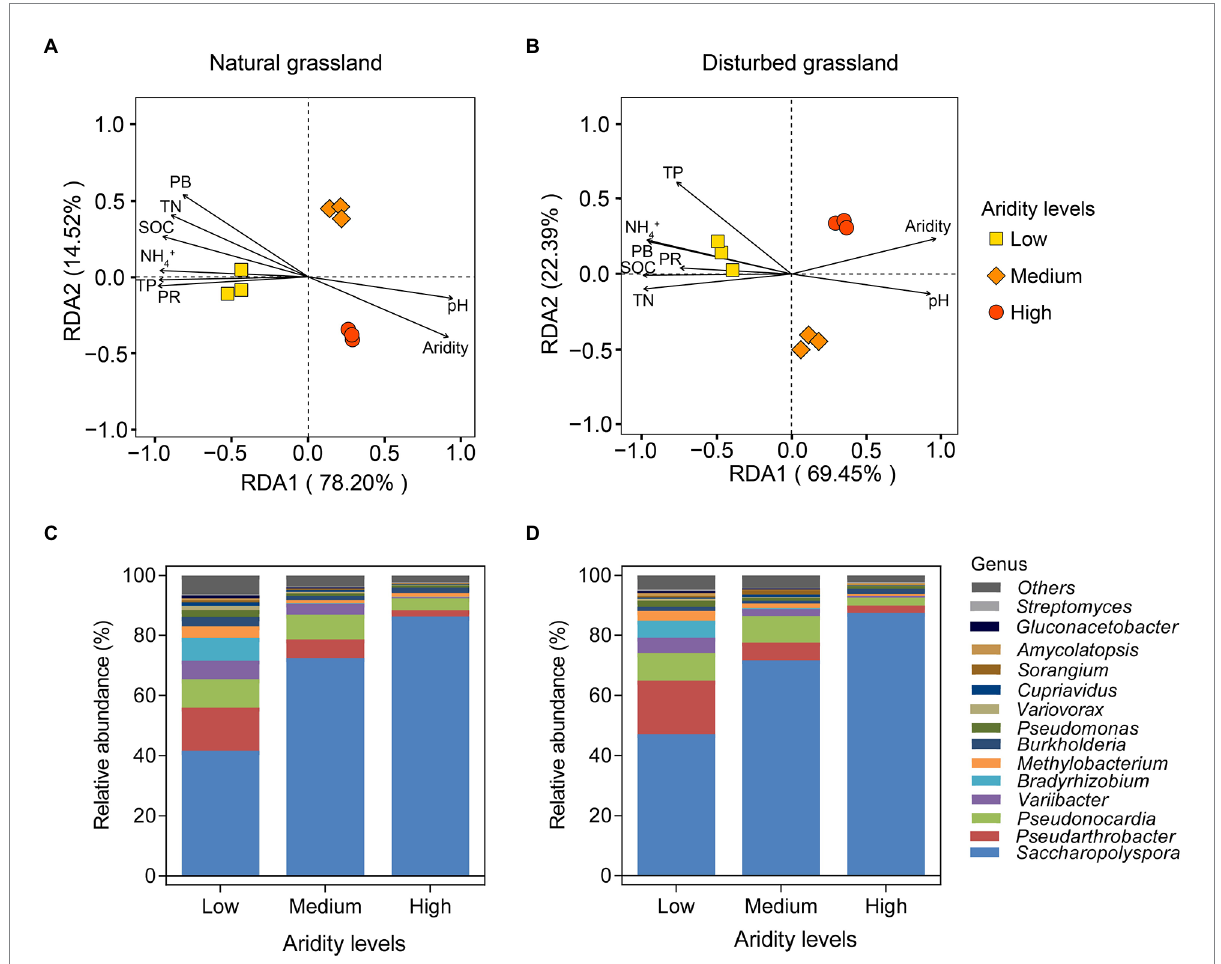
FIGURE 4 Redundancy analysis (RDA) of soil pqqC community and environment variables under different aridity levels in natural (A) and disturbed (B) grasslands. SOC, soil organic carbon; TN, total nitrogen; TP, total phosphorus; PB, plant biomass; PR, plant richness. Relative abundances of the pqqC community at genus level (the top 15 genera) under different aridity levels in natural (C) and disturbed (D)